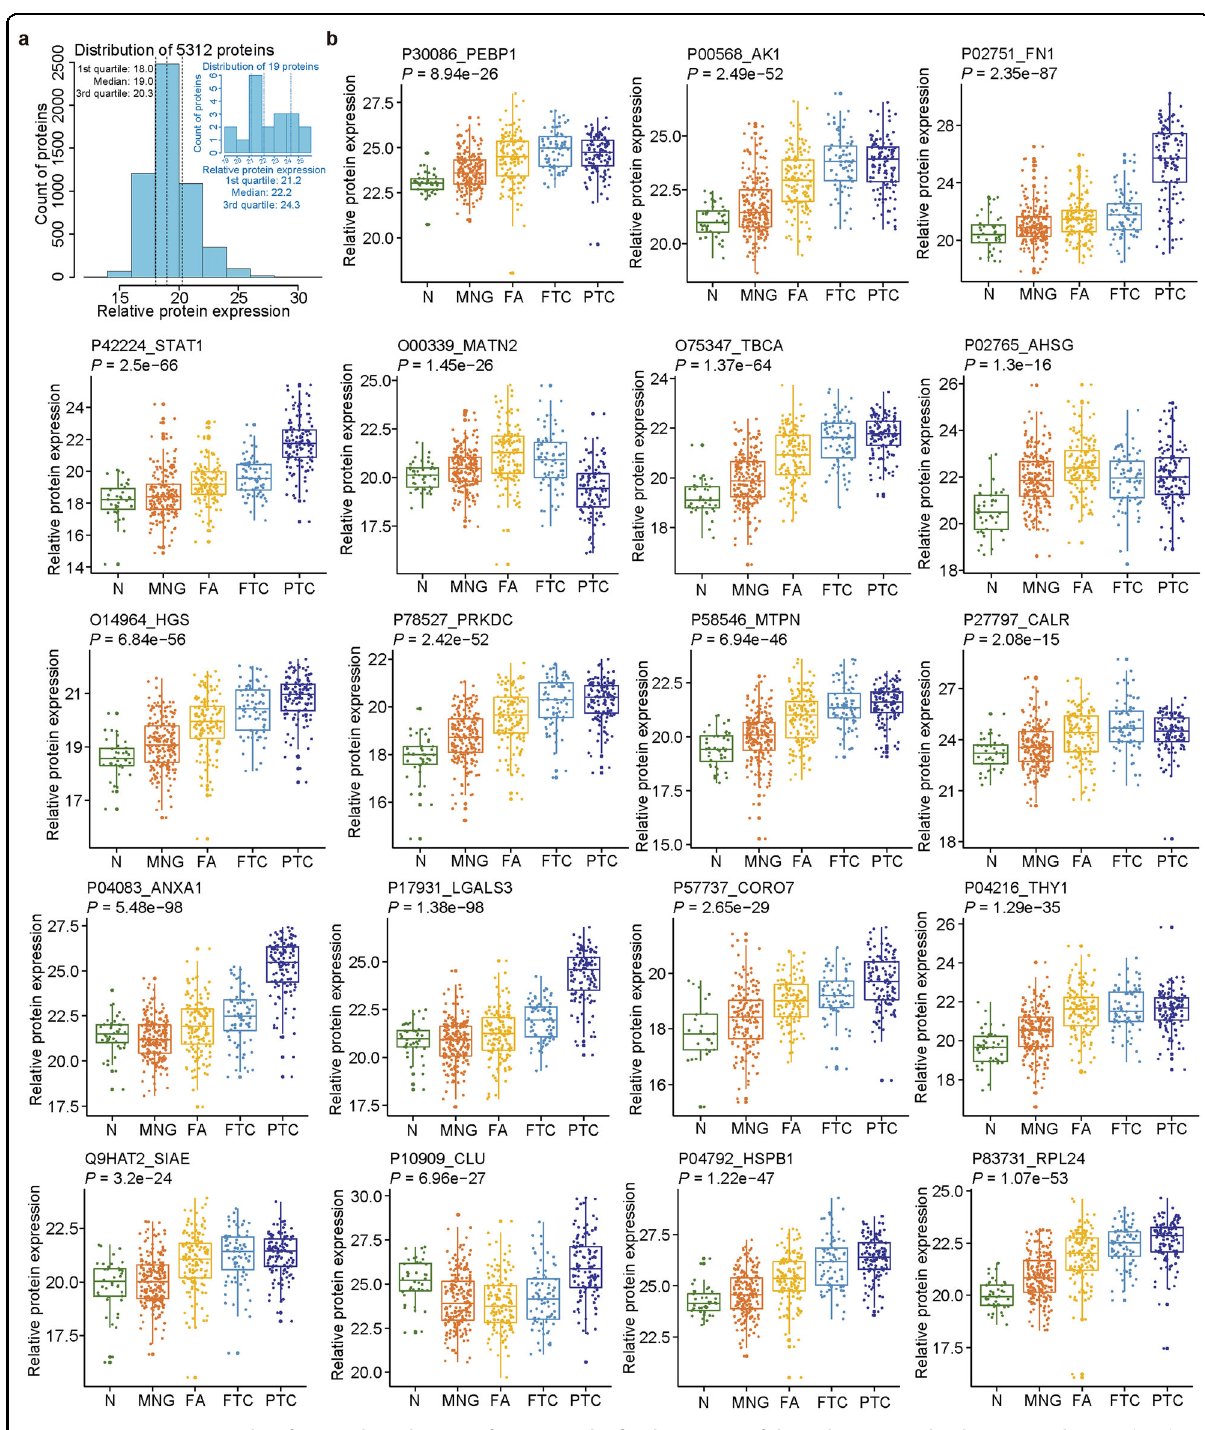
Fig. 4 Protein expression plots for 19 selected protein features in the fi ve histotypes of thyroid tissues in the discovery cohort. a The plots showing the abundance distribution of 5312 proteins and 19 selected features. b y -axis shows log 2 values of protein expression intensity, and x -axis indicates tissue types. P -value was calculated by one-way